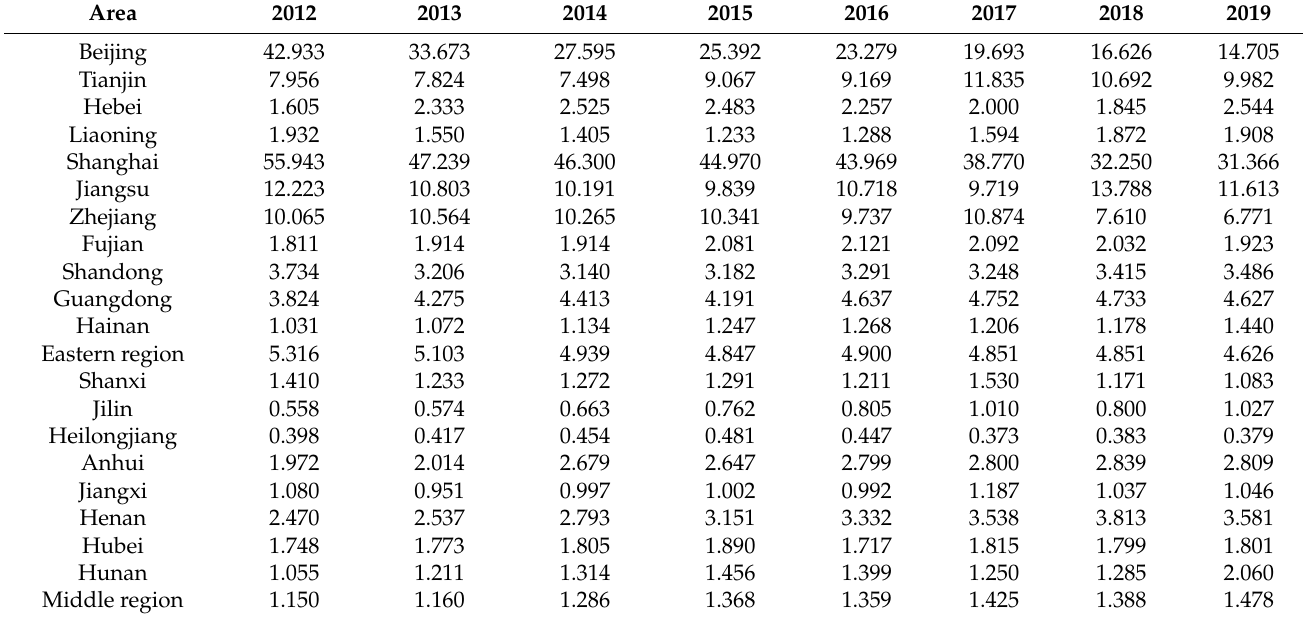
the eastern region was much higher than those in the central and western regions. Table 10. The HRAD i of GP allocation in 2012–2019 in